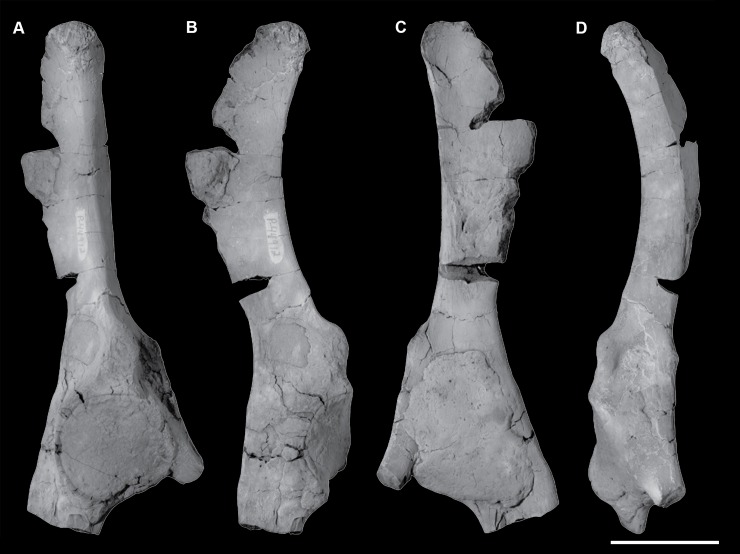
Innominate of Periptychus carinidens (NMMNH P-44917).(A) lateral view; (B) dorsal view; (C) medial view; (D) ventral view. Scale bar: 30mm.